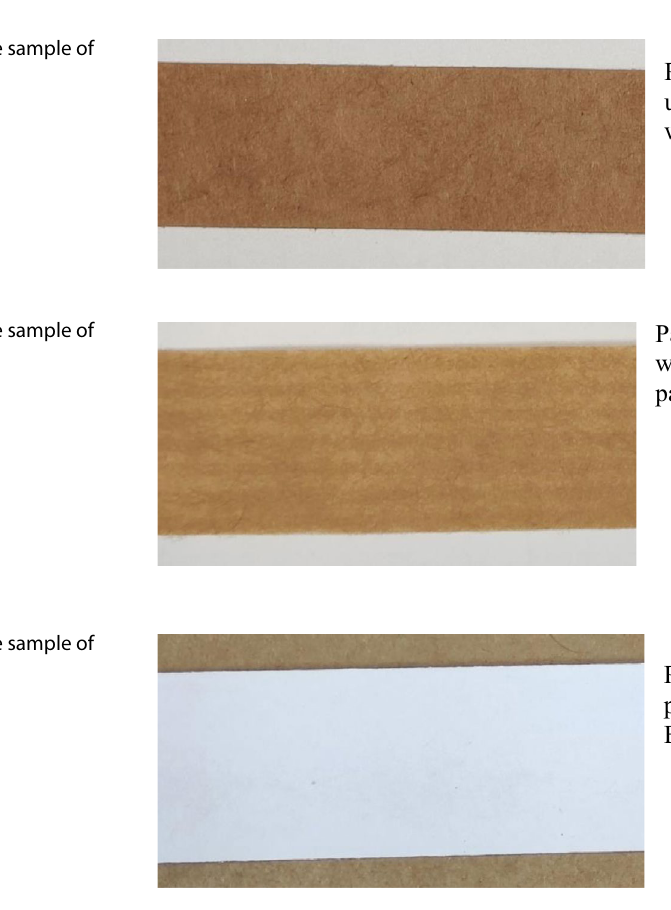
Fig. 21 15 mm wide sample of paper H Paper H: unbleached kraft paper with